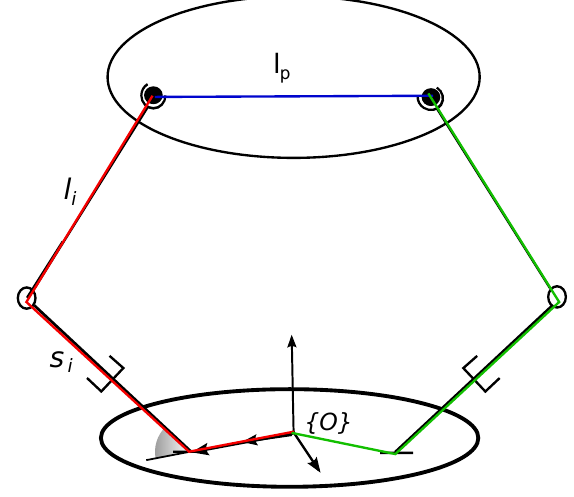
Figure 1. Closed chain equation for finding G I